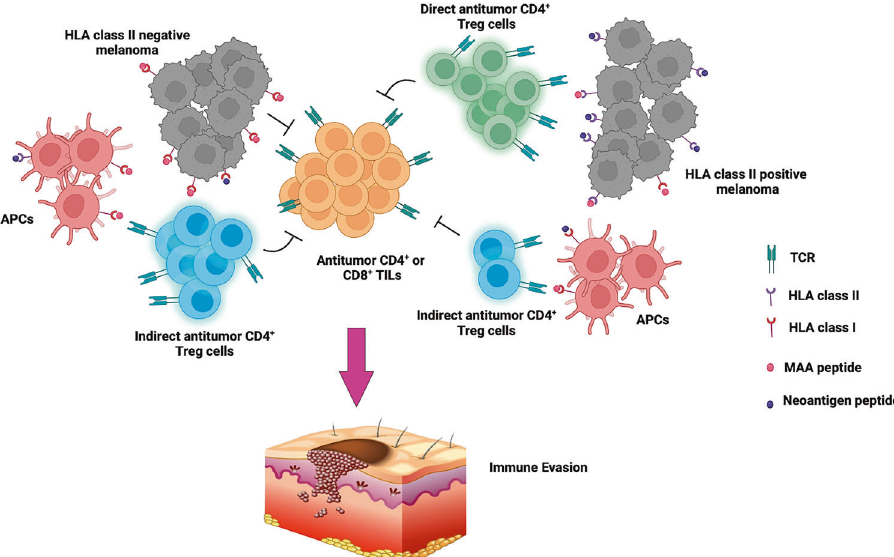
Fig. 1 Novel mechanism of melanoma HLA class II-driven immune escape. With the assistance of indirect antitumor CD4 + Treg cells presented by Antigen-presenting cells (APCs), and direct antitumor Treg cells (major tumor-reactive cells), HLA class II positive melanoma cells evade immune surveillance. In addition, Melanoma directly induced cytotoxic CD4 + T cells depletion through HLA class I, but not directly induced Treg production through HLA class I. The fi gure was generated on